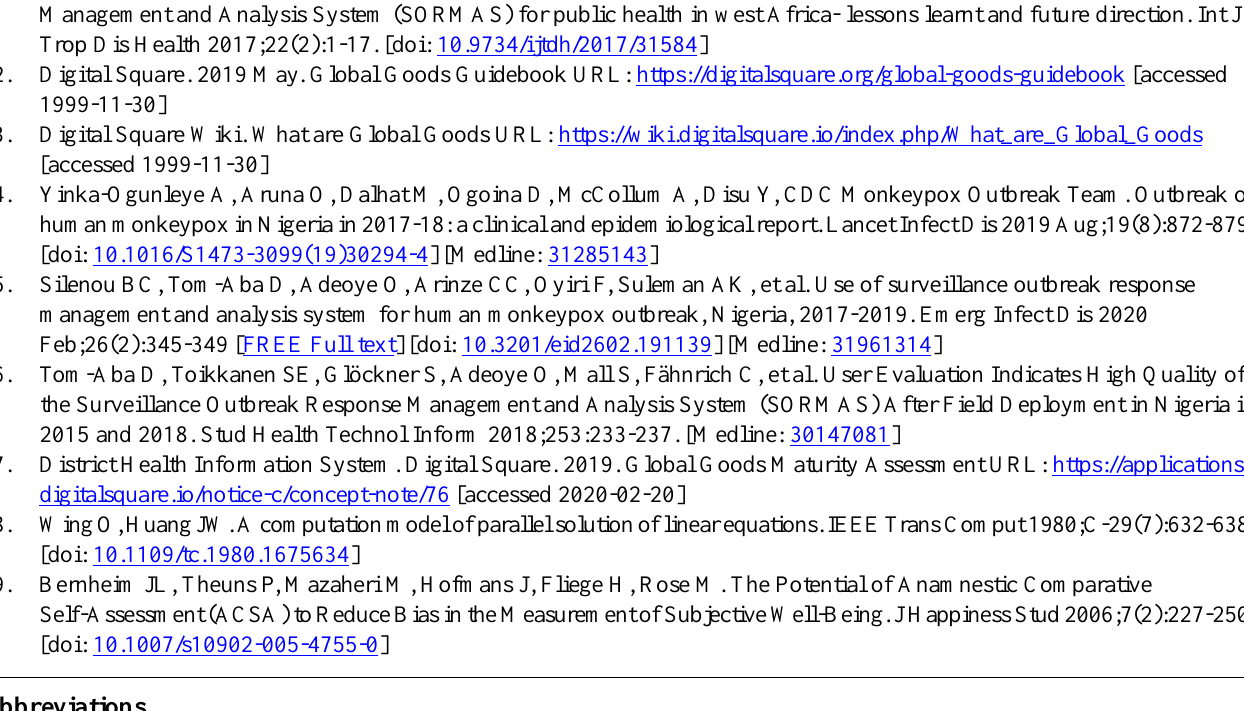
Abbreviations GGMM: global good maturity model LGA: local government